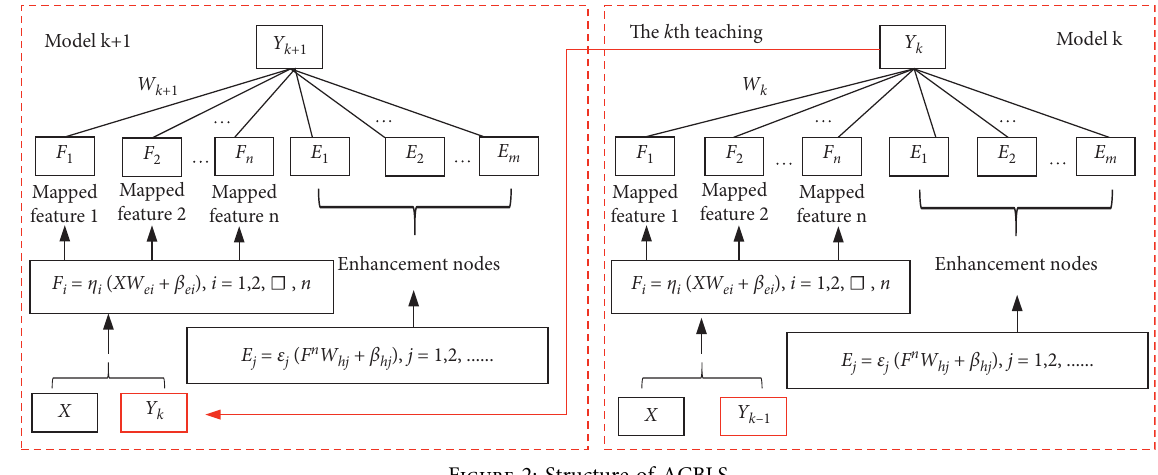
Figure 2: Structure of ACBLS